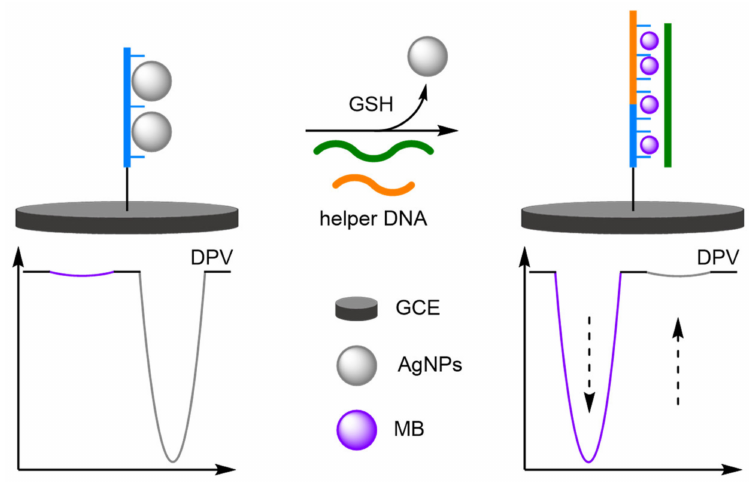
Figure 25. Schematic representation of a hybridisation chain reaction-based biosensor with intercalation-assisted label